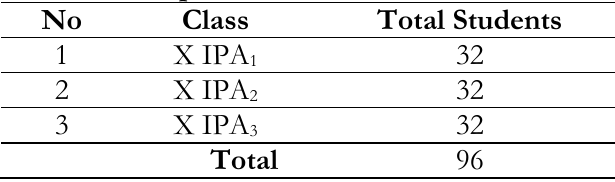
TABLE 3.1 Population of the research